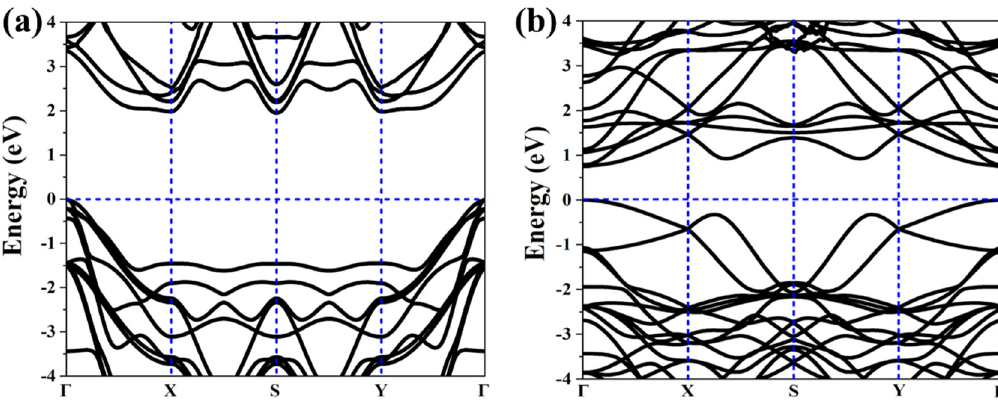
Figure 5. Six structures constructed by stacking( a–c ) and jointing( d–f ) α -TeB and β -TeB.